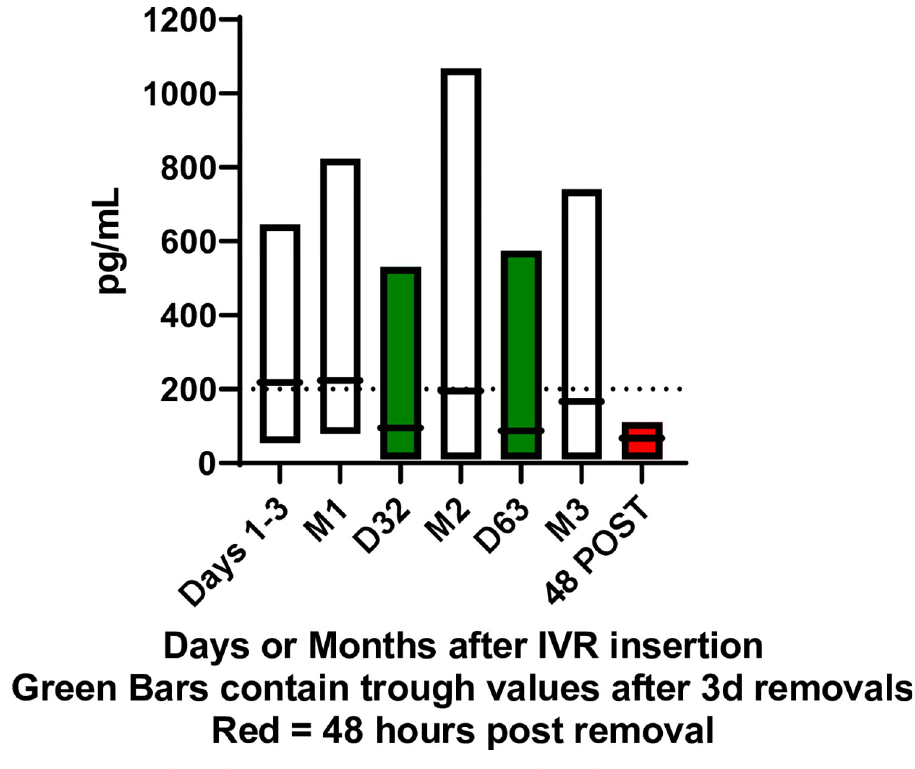
Fig 6. Serum LNG (pg/mL) in TFV/LNG continuous IVR Users (n = 18) and in TFV/LNG interrupted IVR users IVR users (n =